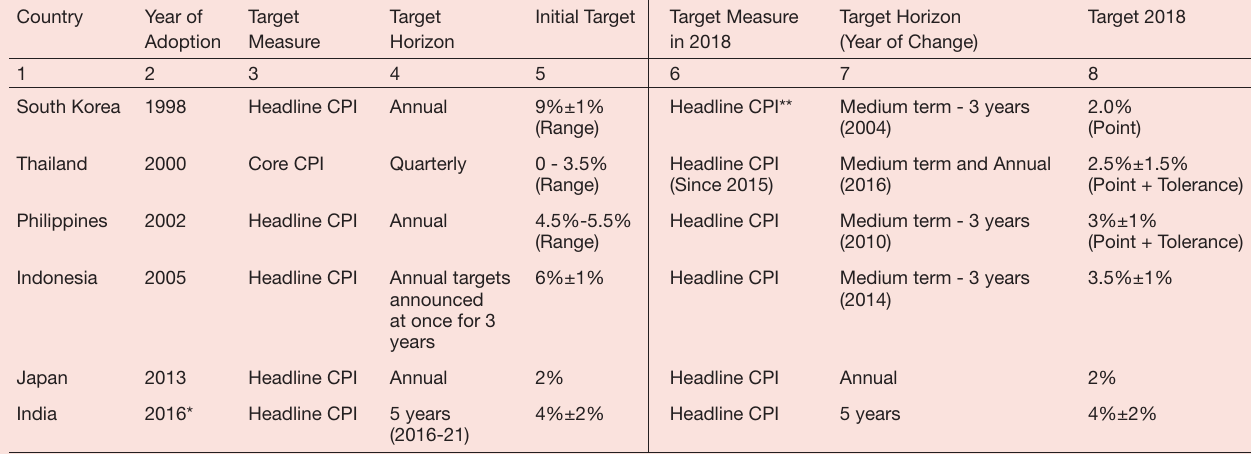
Table 2: evolution of Inflation Targeting in Select asian